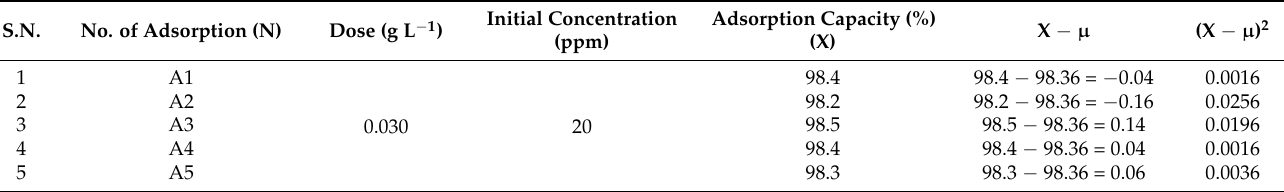
Table 9. Details of the comparison of the % removal of RhB dye using different doses of AC (Db-s) and commercial carbon.